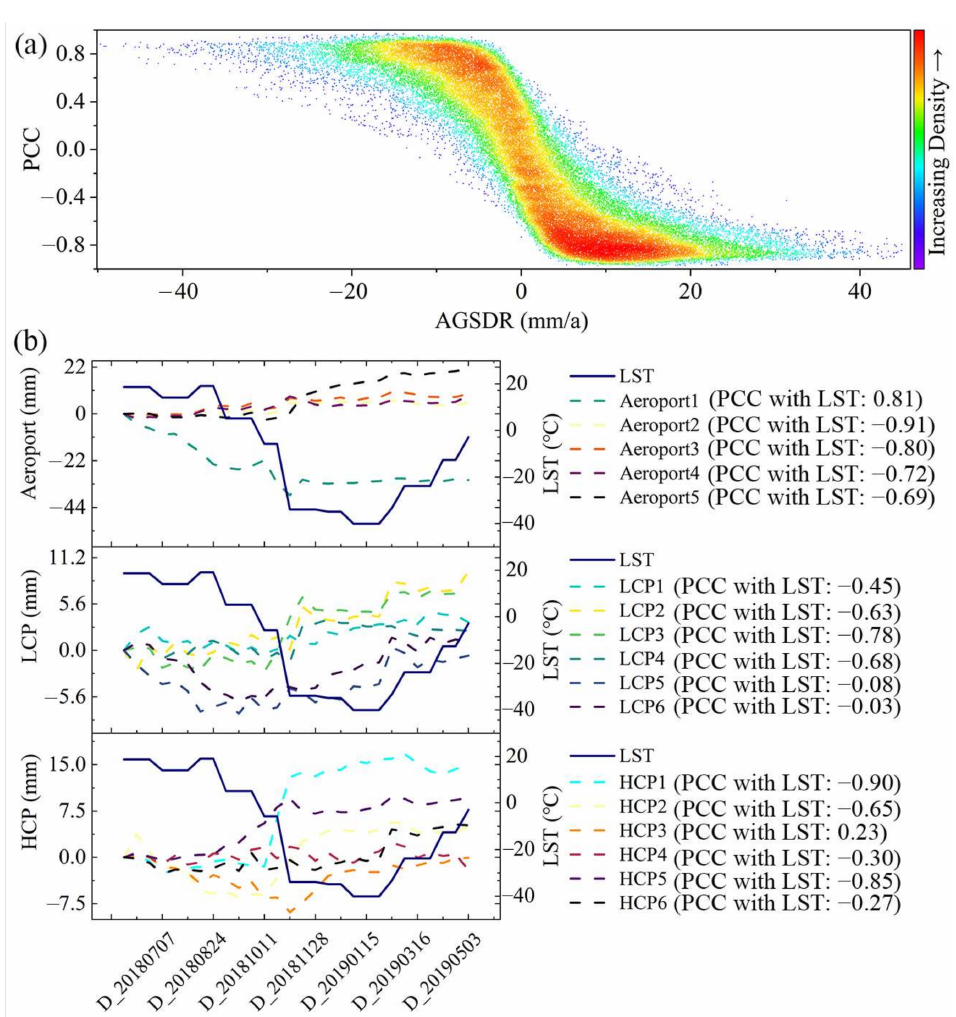
Figure 5. Ground surface deformation (GSD) of different IWP sites in representative areas in Sasky- lakh, northwestern Yakutia. Notes: ( a ) is the distribution of correlation between GSD and LST in annual ground surface deformation rate (AGSDR); ( b ) is the GST of LCP, HCP, and Aeroport in different regions. Notes for acronyms: LST: land surface temperature calculated by MODIS; LCP: low-centered polygon; HCP: high-centered polygon; PCC: Pearson correlation